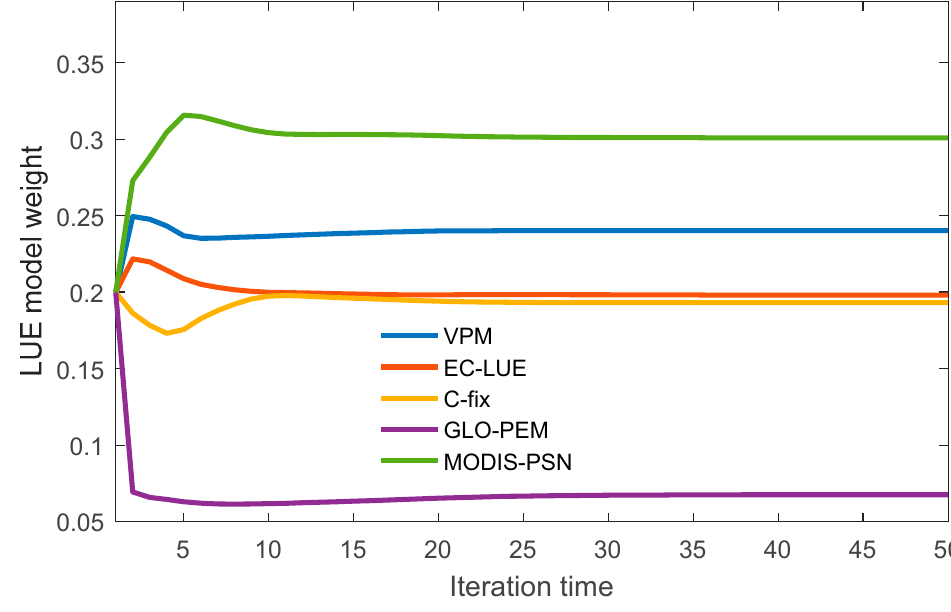
Figure 4. The weights convergence trajectory of the LUE models during the BMA method training. Table 4. Determinant coefficients and RMSEs between the simulated GPP and the EC-measured GPP. (Data measured during 2014/2015 was used to train/validate the BMA method. The highest R 2 and the smallest RMSE were bolded.).